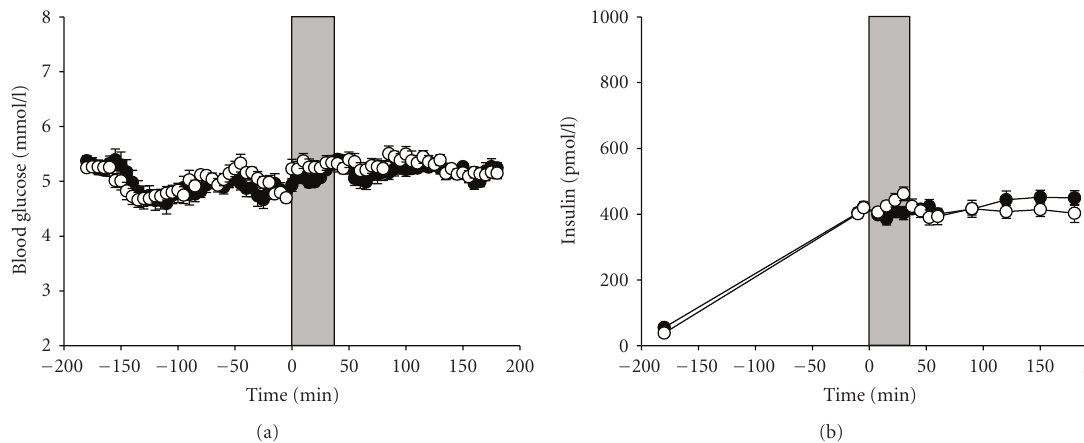
Figure 1: Mean ( ± SEM) blood glucose concentrations (a) and plasma insulin (b) in the hypoxic (white circles) and the control (black circles) condition. Gray area marks the time of hypoxic/normoxic intervention. The time course describes the period before and after the hypoxic intervention was initiated (Time point 0).